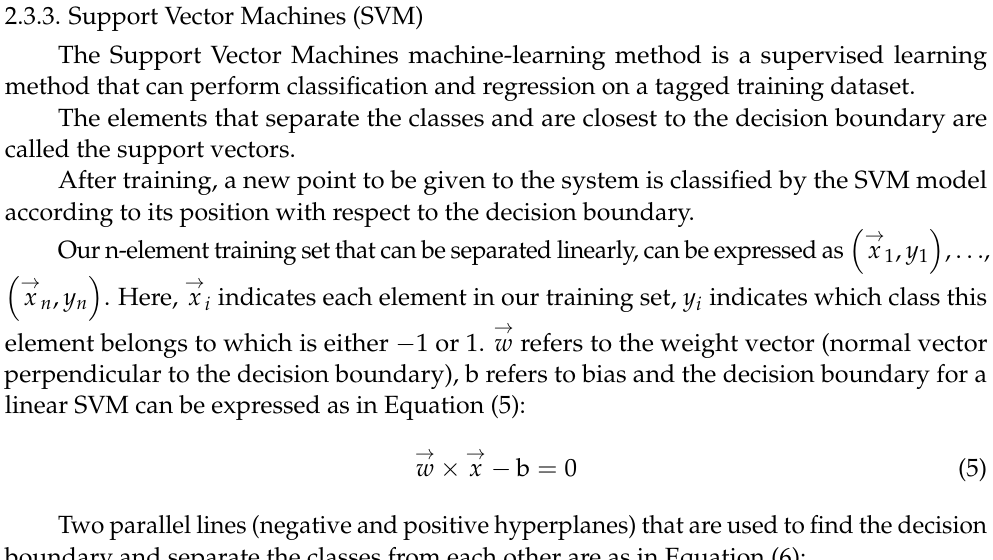
Figure 5. Forming the LBP histogram, the image was taken with the permission of Kelvin Salton do Prado from his article titled “Face Recognition: Understanding LBPH Algorithm” [60].